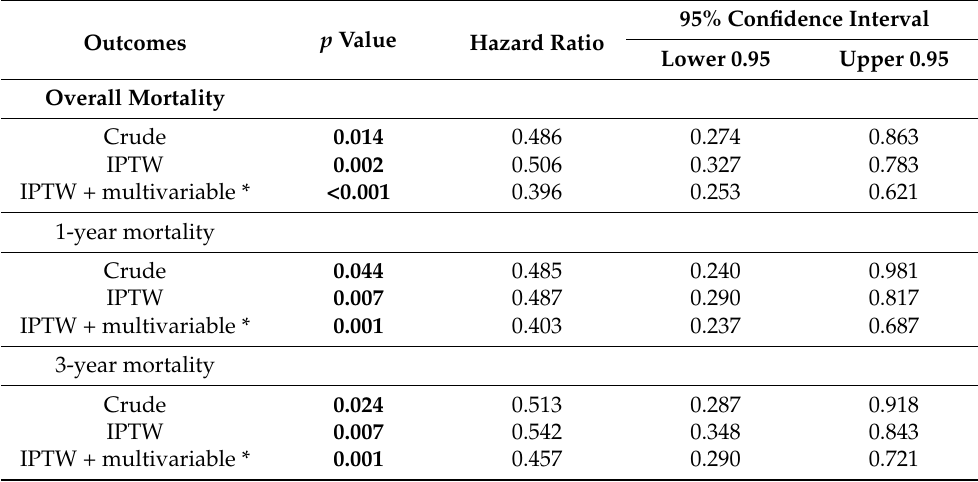
Figure 3. Kaplan–Meier post-heart transplantation survival curves for overall survival in patients who underwent heart transplantation with the multidisciplinary team approach (MDT group; green line) and without the multidisciplinary team approach (non-MDT group; blue line). MDT, multidis- ciplinary team. Table 3. Adjusted hazard ratios for overall, 1-year, and 3-year mortality following the MDT group compared with the non-MDT